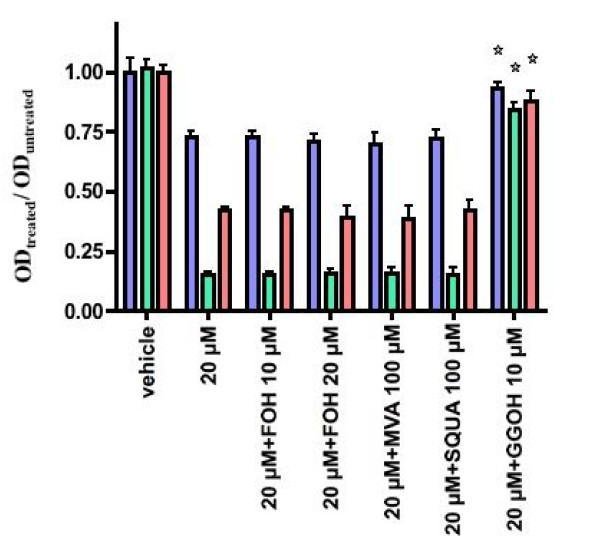
Effect of mevalonate-derived products on 20 μM zoledronate-induced inhibition of prostatic cell proliferation. At D0, cells were seeded into 96-well plates to obtain 80% confluence at D5 in control wells. At D1, and D3, cells were treated by vehicle or 20 μM zoledronate (ZOL) in the presence or absence of intermediates of the mevalonate pathway (GGOH = geranyl-geraniol; MVA = mevalonate; FOH = farnesol; SQUA = squalene) at the indicated doses. Results are are expressed as the ratio ODtreated cells/ODuntreated of three independent assays each performed six times. Error bars indicate inter-assay mean ± 1 SD. * indicates a significant difference versus ZOL-treated cells (p < 0.01).  PC-3  PNT1A  LNCaP